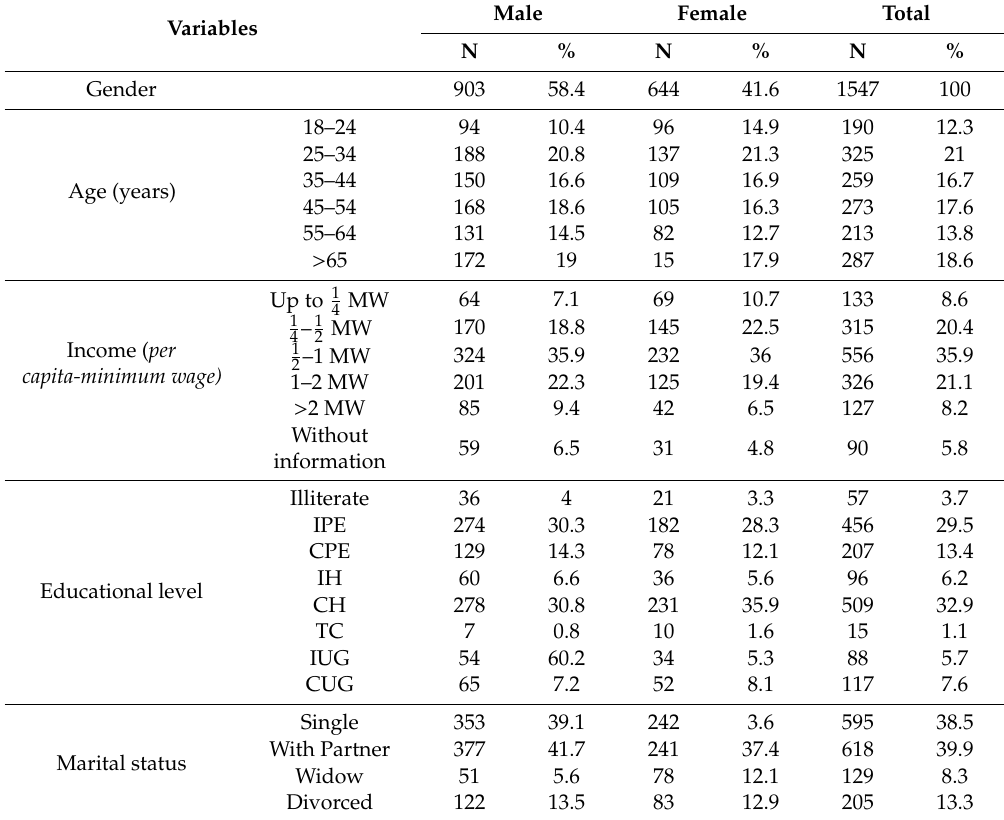
Table 2. Distribution of sociodemographic data frequency among Community Restaurants (CRs) users regarding breakfast